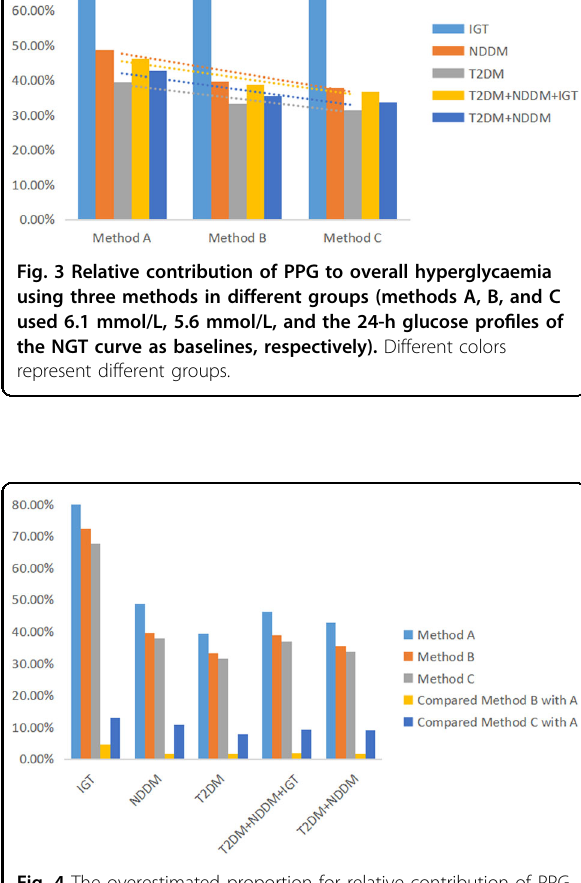
Fig. 4 The overestimated proportion for relative contribution of PPG to overall hyperglycaemia by methods A and B, compared with baseline of the 24-h glucose pro fi les of the NGT in different